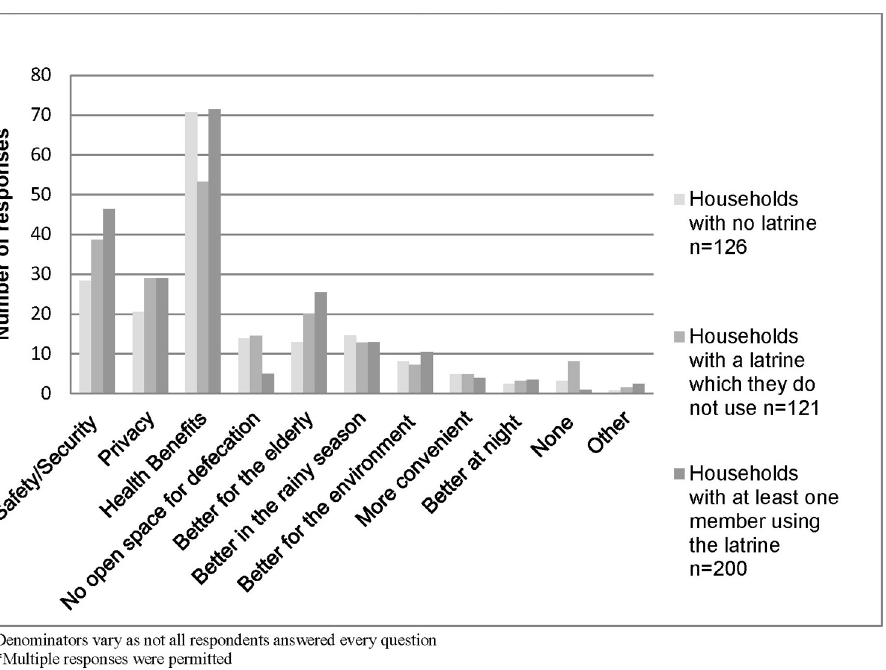
Figure 1. Benefits of latrine use according to respondents. Regardless of whether a household had a latrine, or whether it was in use, the most commonly reported benefit of latrine use was health benefits, followed by safety and security. Households that had a latrine that was in use were less likely to be aware of whether there was no open space for defecation. Few households reported that using latrines were more convenient or better at